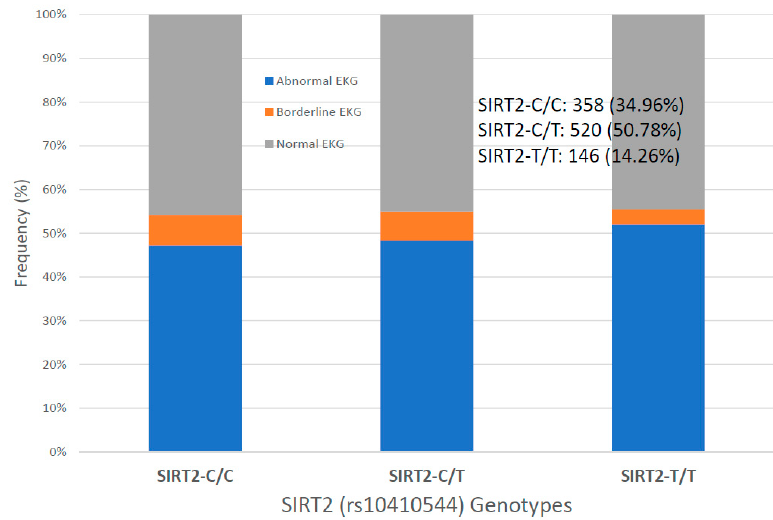
Figure 9. SIRT2 -related blood pressure values in Alzheimer’s disease.